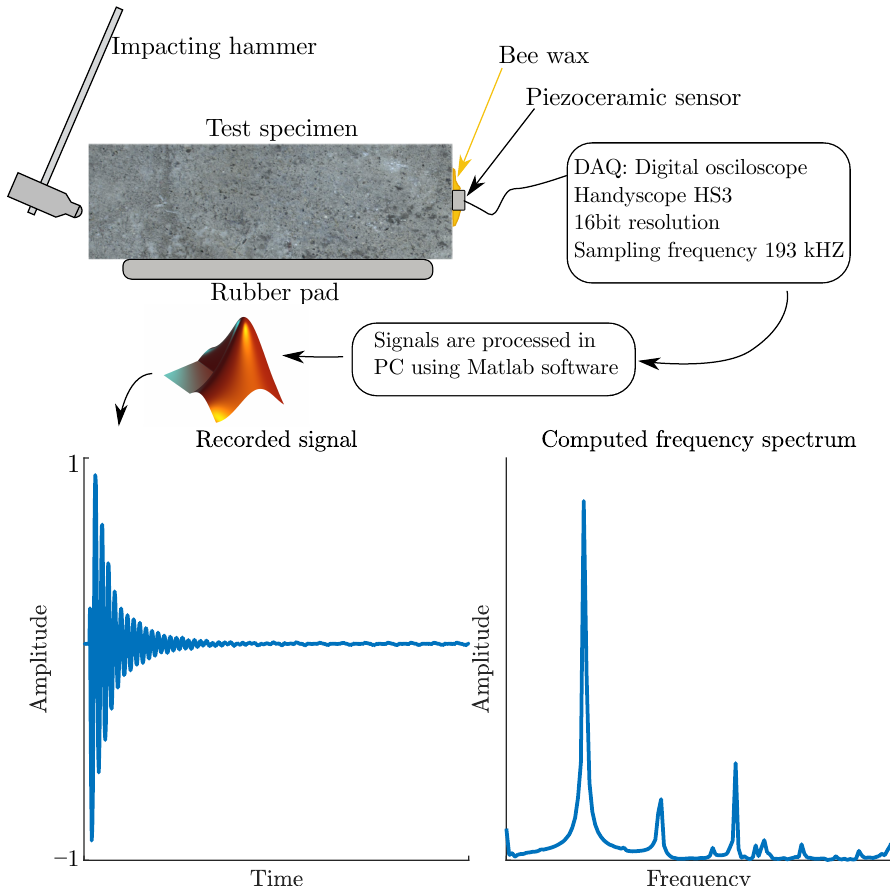
Figure 3. Illustration of measurement process by IE